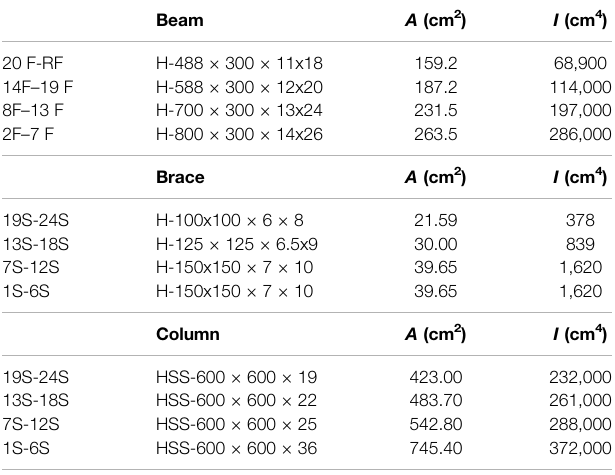
TABLE 4 | List of sections of 24-story